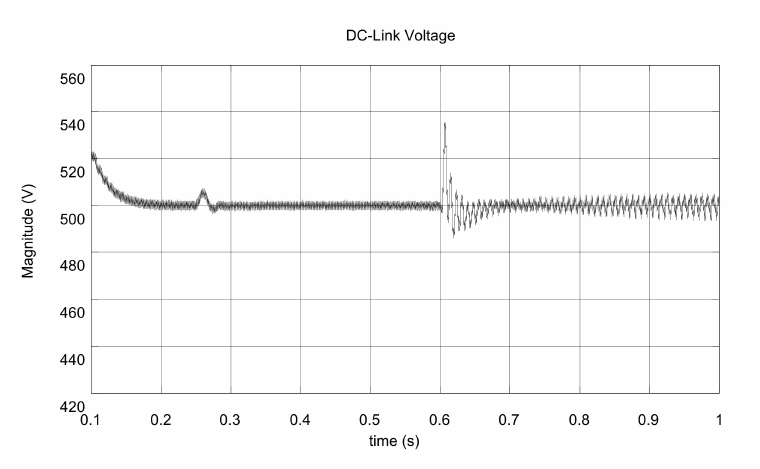
Figure 27. DC-link capacitor voltage under ‘type B’ voltage